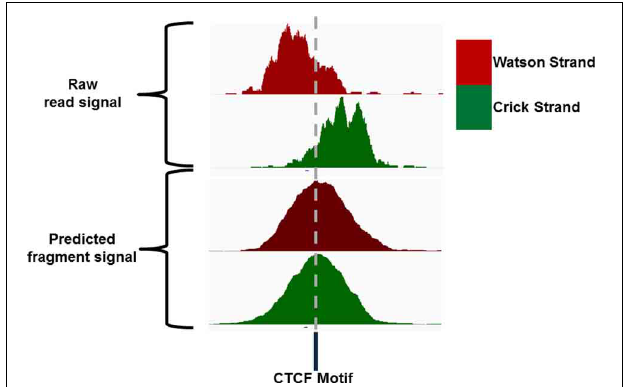
FIGURE 4 | IGV screenshot of an example CTCF ChIP signal showing the distribution of Watson and Crick signal around the CTCF motif and the distribution of Watson and Crick signal following extension of reads to the expected fragment